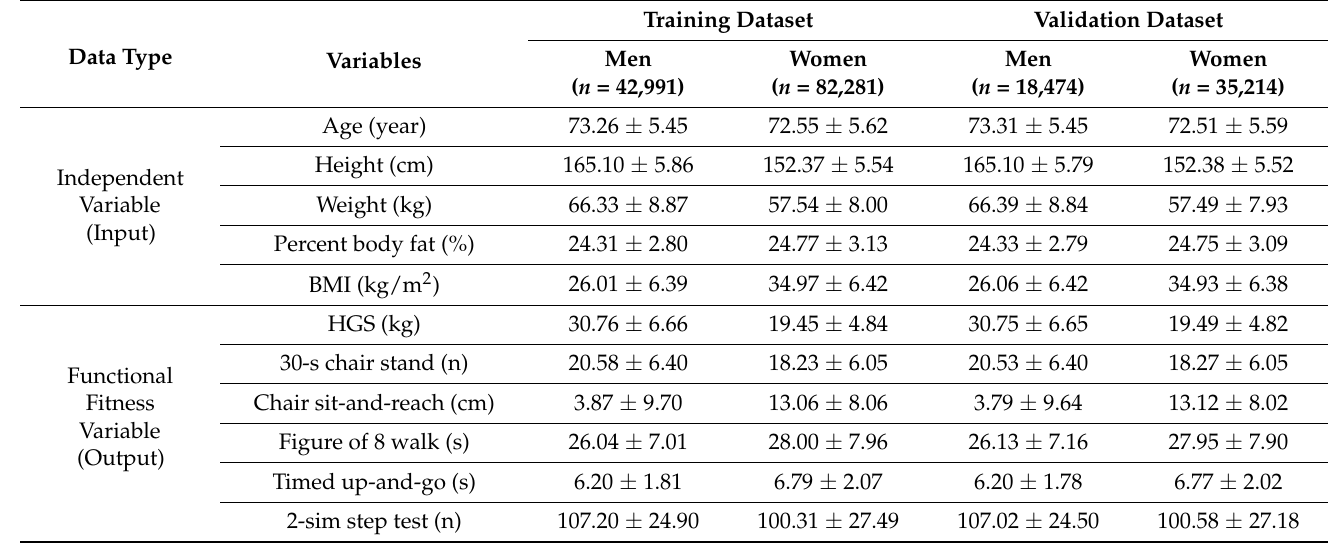
Table 1. Summary of the NFA dataset used to train the FF variable estimation